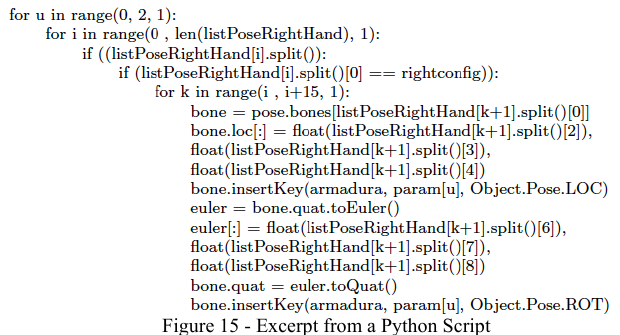
Figure 15 - Excerpt from a Python